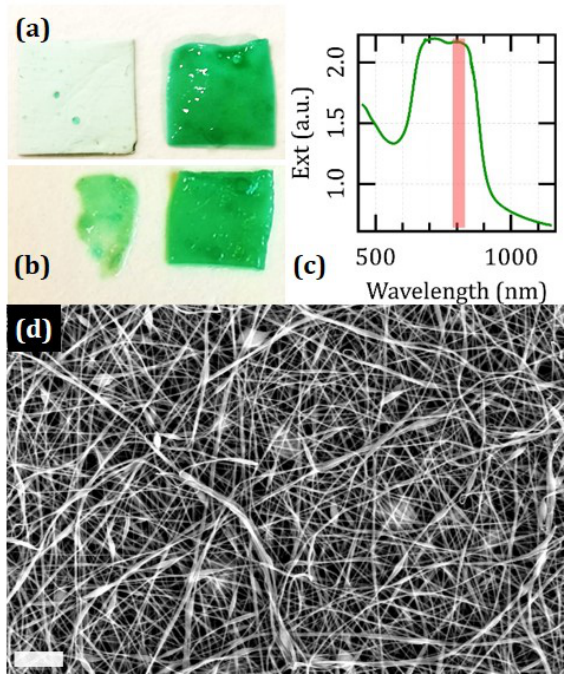
Figure 1. Visual appearance and ultrastructure of the films: Photographs of specimens of the films of a size around 1 cm 2 ( a ) before ( left ) and after ( right ) hydration in a physiological buffer and ( b ) upon hydration before ( left ) and after ( right ) cross-linking. The green spots in the dry sample are usual defects originating from occasional instabilities and dripping in the process of electrospinning. Note that the sample before cross-linking undergoes partial dissolution upon soaking in physiological buffer for 30 min, and so it is only partially recovered after hydration. ( c ) Spectrum of optical extinction of a cross-linked sample after a slight hydration taken with a V-770 device from Jasco (Tokyo, Japan). The pink line represents the optical emission of the diode laser used for welding. ( d ) Representative SEM micrograph of a sample before hydration. The scale bar corresponds to 5 µ